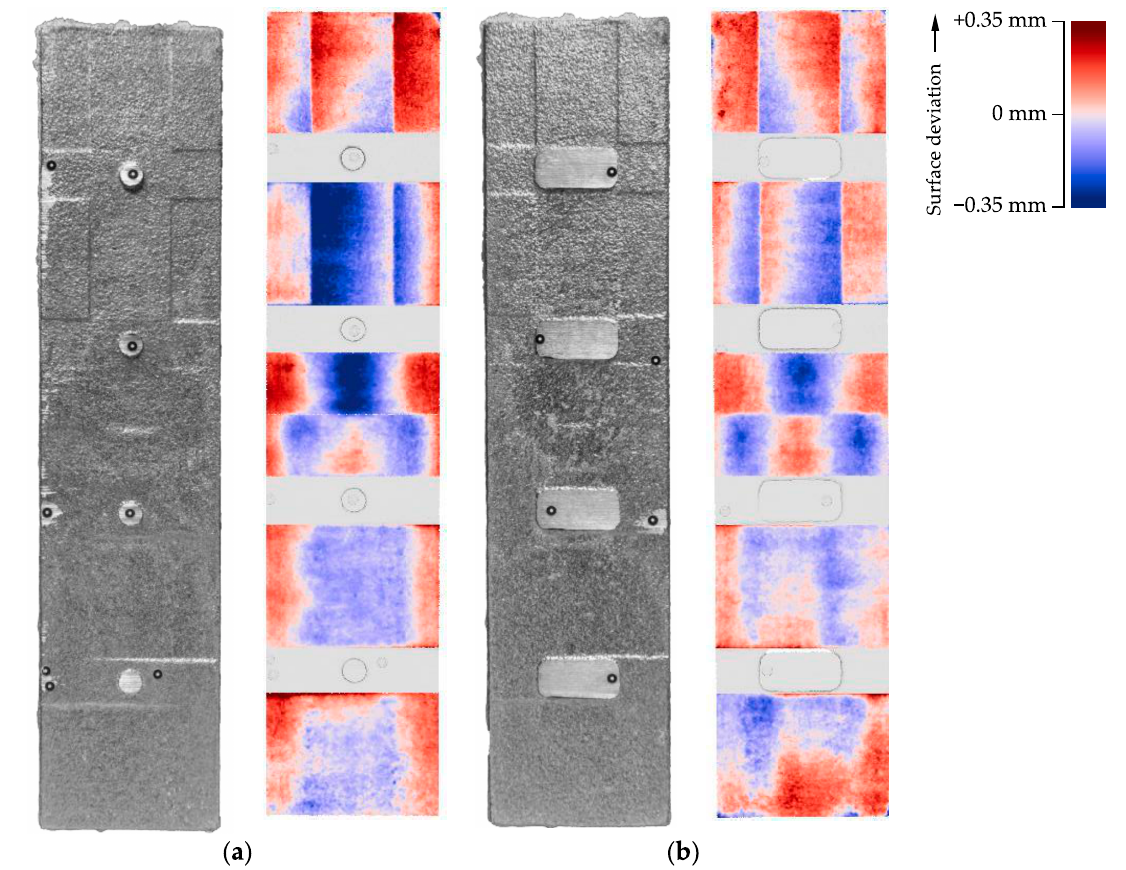
Figure 14. ( a ) Upside of cast part; GOM measurement of the upside; ( b ) Downside of cast part; GOM measurement of the